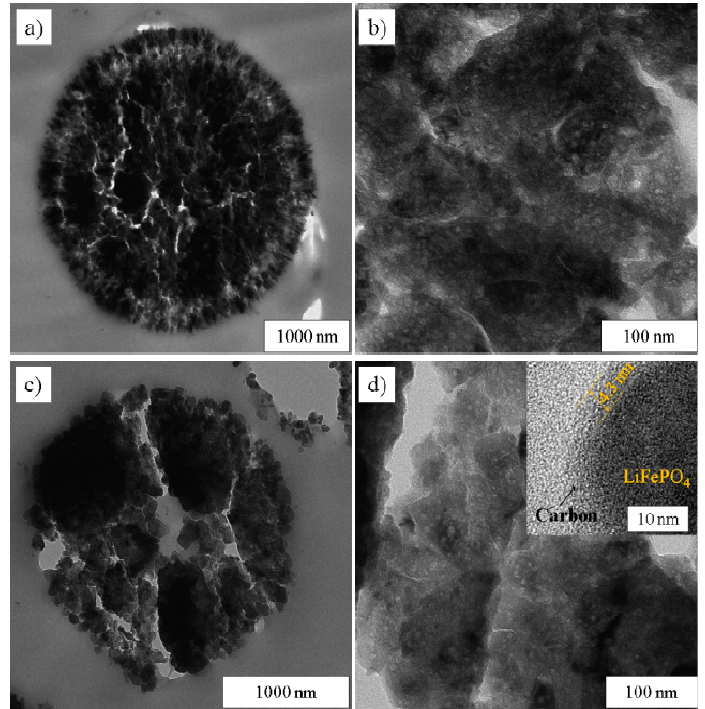
Figure 3. TEM images of ultramicrotome cross-sections of LiFePO ( a ) and ( b ) LFP180-2-700; ( c ) and ( d ) LFP250-1-700; ( b ) and ( d ) are magnified images from inner parts. The insert in ( d ) is a high resolution tunnelling electron microscopy (HRTEM) image of